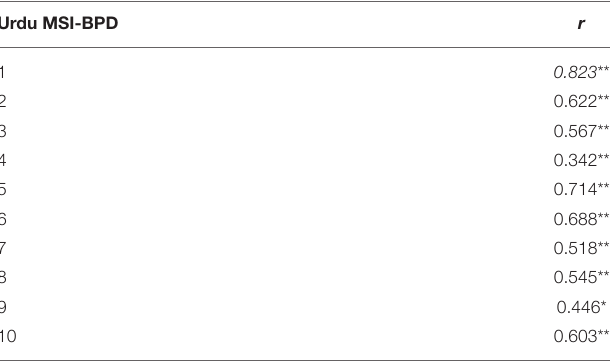
TABLE 2 | Item total correlation for the Urdu MSI-BPD ( N = 150).